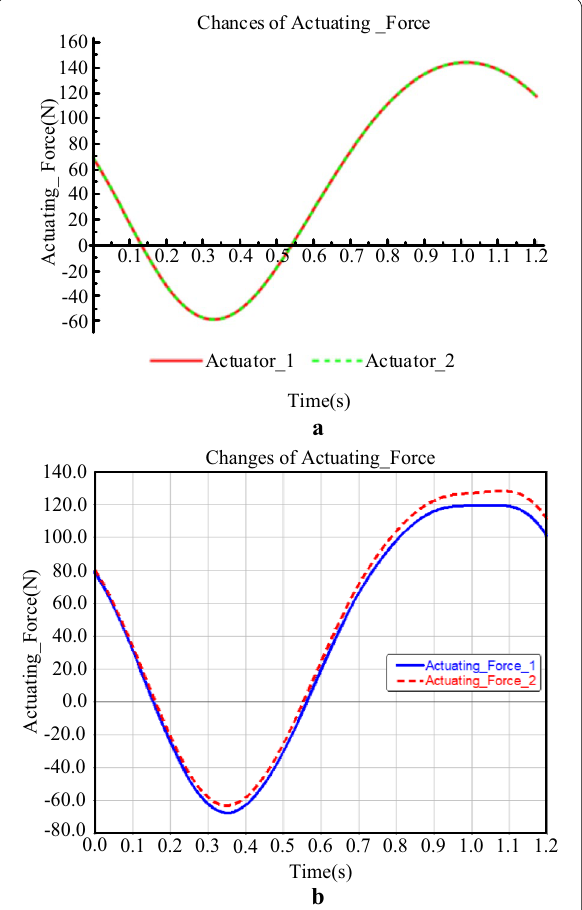
Figure 17 Actuating forces in the first gait mode: a actuating forces by Mathematica; b actuating forces by